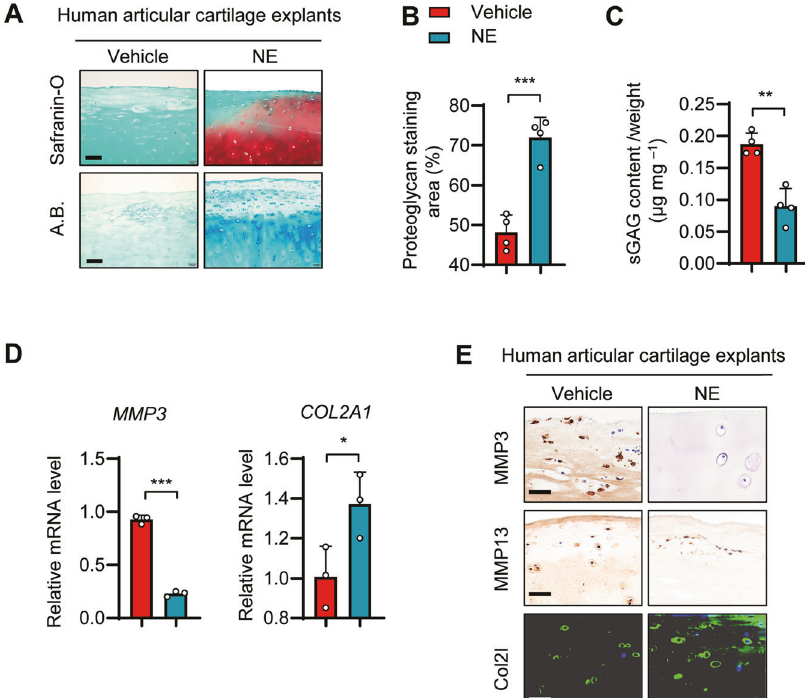
Fig. 5 Inhibition of GPR4 promoted ECM production and suppressed cartilage catabolism in human articular cartilage explants. A – C Representative images of Safranin-O staining and Alcian blue (A.B.) staining in human articular cartilage explants. Relatively intact articular cartilage explants were cut from knee OA patients, and then the explants were treated with vehicle control or GPR4 antagonist NE52- QQ57 (NE, 10 μ M) for 1 week. The explants were collected and subject to Safranin-O staining ( A ). Proteoglycan staining area (%) was analyzed ( B ). The sulfated GAG (sGAG) released from explants was measured by 1, 9, dimethyl methylene blue (DMMB) binding assay ( C ). The released amount of sGAG was normalized to the wet weight of the cartilage explant. n = 4, Data are presented as mean ± s.d. ** p < 0.01, *** p < 0.001, using unpaired two-tailed Student ’ s t test. Scale bar, 100 μ m. D The mRNA levels of MMP3 and COL2A1 in human articular cartilage explants treated with or without NE52-QQ57 (10 μ M) for 1 week were determined by qRT-PCR. n = 3, data are presented as mean ± s.d. * p < 0.05, *** p < 0.001 using unpaired two-tailed Student ’ s t test. E Representative images of IHC and immuno fl uorescence staining of MMP13, MMP3, and COL2 of human articular cartilage explants treated with or without NE52-QQ57 (NE, 10 μ M) for 1 week. Scale bar, 50 μ